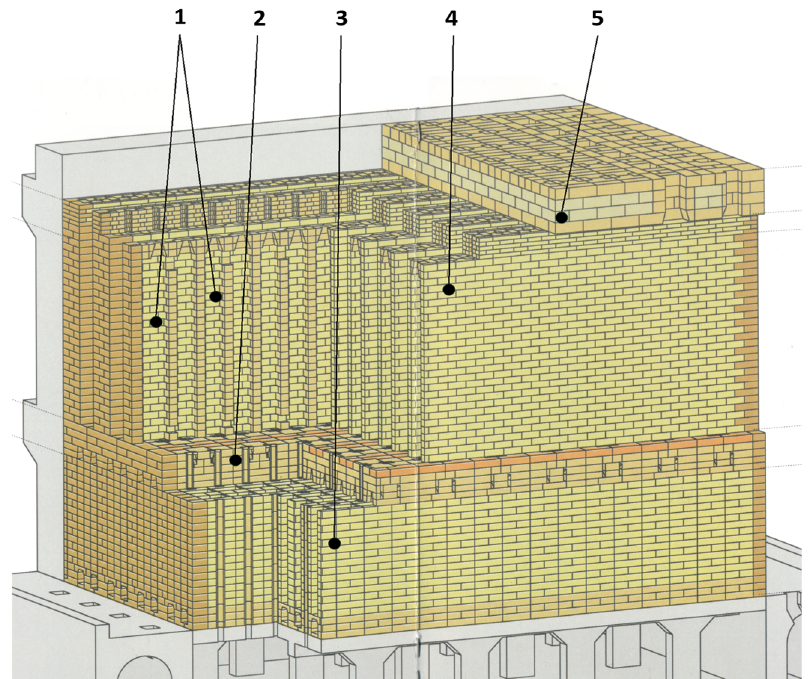
Figure 1. Cross-section of the coke oven battery (1—heating flues, 2—coking chamber shaft and floor, 3—regenerators, 4—brickwork of coking chambers and heating walls, 5—vault and roof).